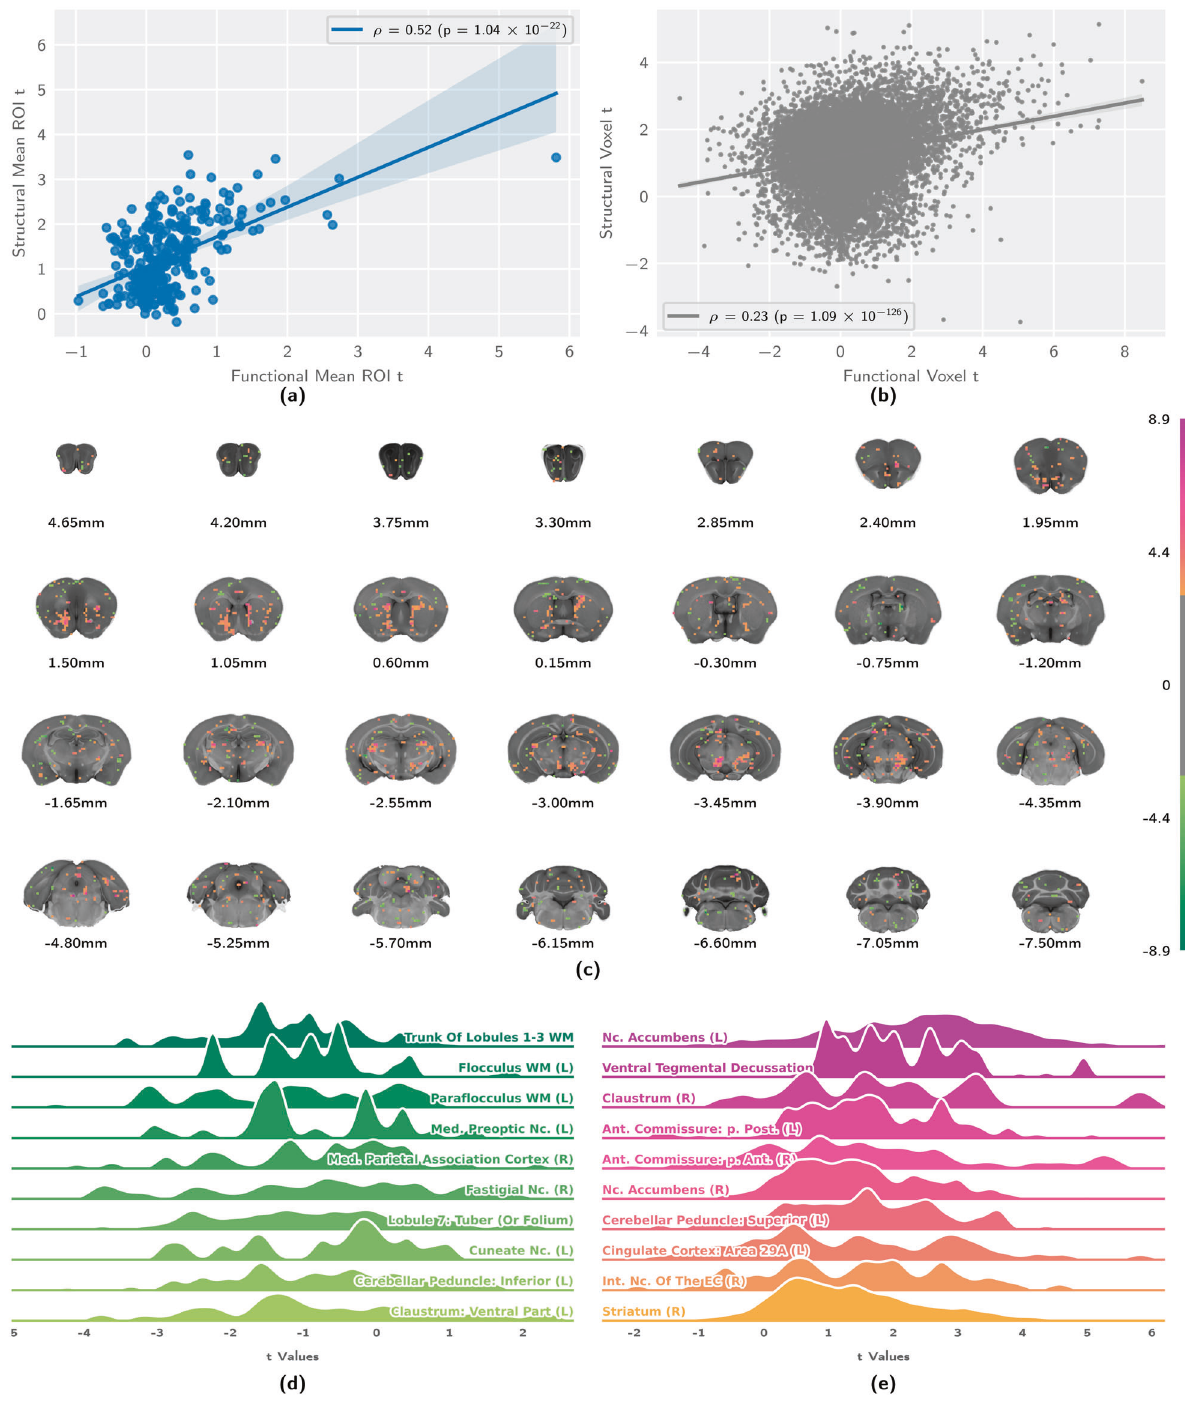
Fig. 4 Comparing VTA functional activation to structural projection data reveals good correspondence, with deviations involving the dorsomedial striatum and the contralateral ventral striatum. Depicted are correlation analyses ( a, b ) of the population-level functional and structural statistic scores, alongside statistic distributions ( c – e ) for the contrast, taking into account variability across subjects. a Region-wise regression plot between functional and structural projection maps. Tinted area indicates the 99% con fi dence interval of the regression estimate. b Voxelwise regression plot between functional and structural projection maps. Tinted area indicates the 99% con fi dence interval of the regression estimate. c Coronal slices, showing the population-level contrast t-statistic between VTA functional activation and VTA structural projections. d Distribution densities of t-statistics, showing the regions where VTA structural projection exceeds functional activation most strongly. e Distribution densities of t-statistics, showing the regions where VTA functional activation exceeds structural projection most strongly. Ant. Anterior, EC endopiriform claustrum, Int. intermediate, Med. medial, Nc. nucleus, p. pars, Post. posterior, WM white